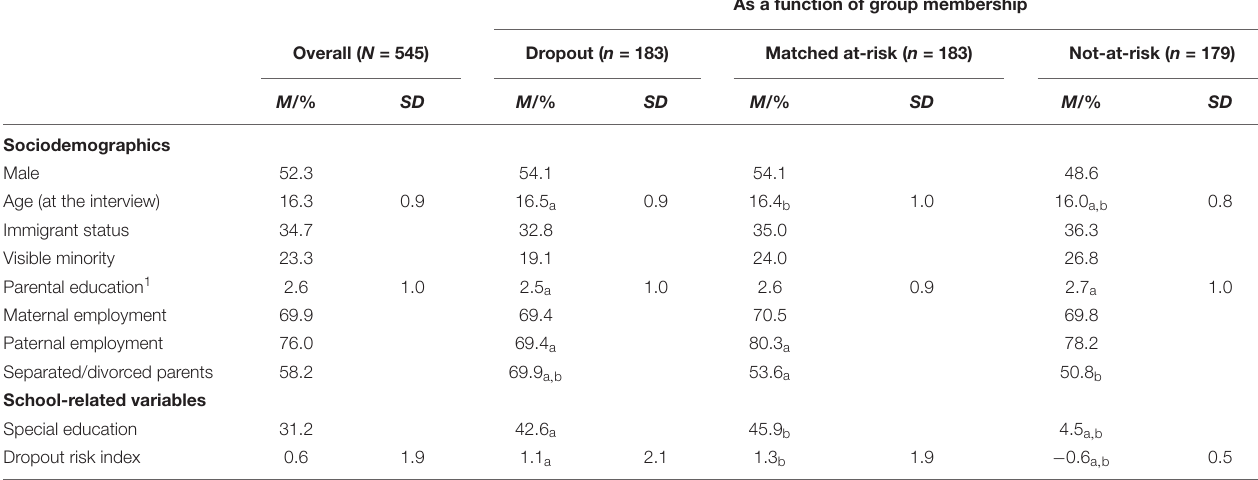
TABLE 1 | Participant